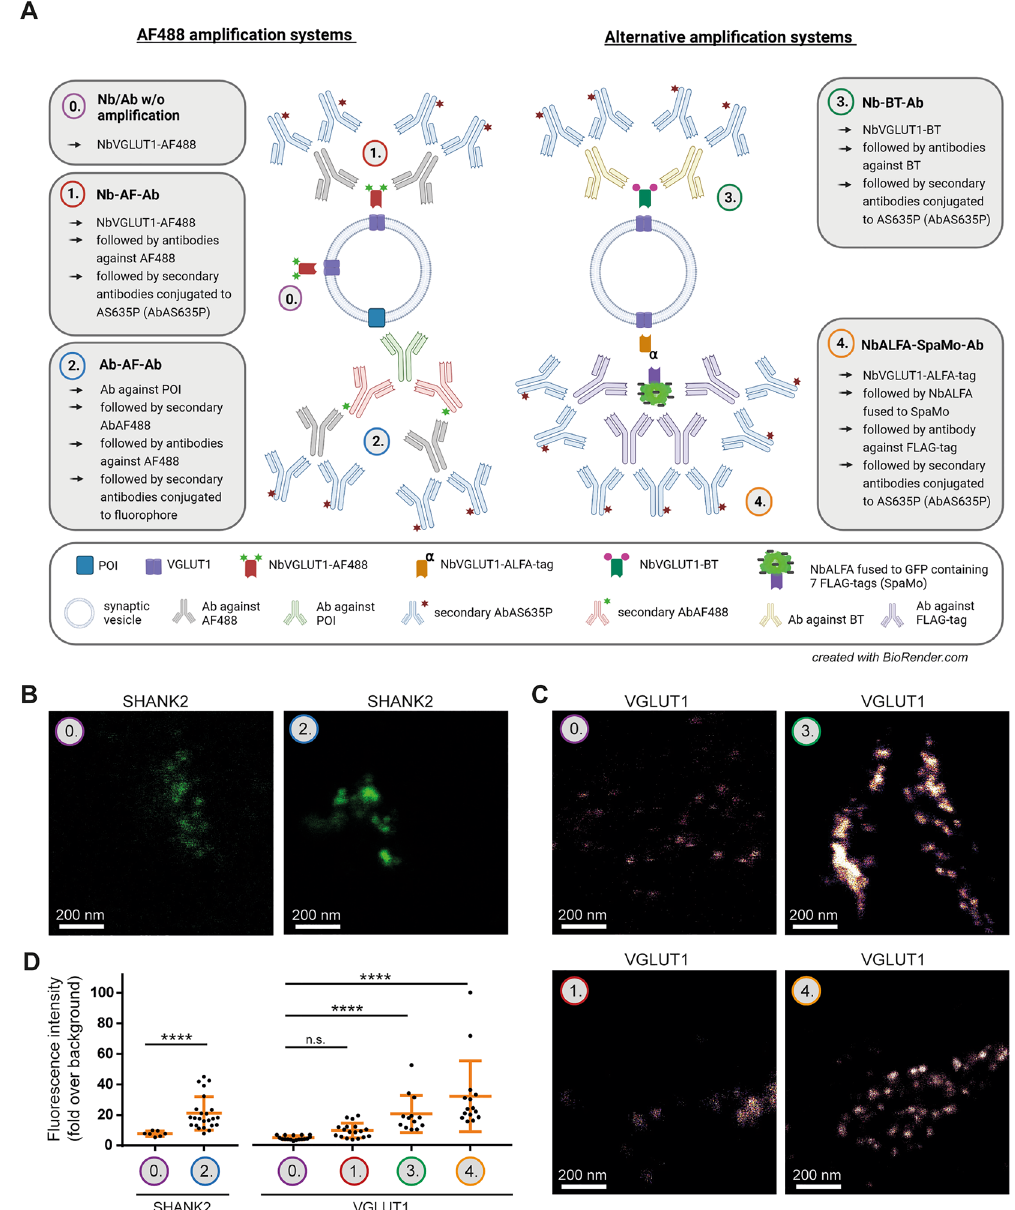
Figure 4. Pre-expansion labeling of presynaptic markers with different signal amplification systems in X10ht. ( A ) Schematic visualization of the different amplification systems. See the main text for more details. Final used fluorophores are Alexa Fluor488 (AF488) or Abberior Star635P (AS635P). ( B ) Representative confocal images of expanded neurons immunostained with either the antibody-AF488-based amplification system for SHANK2, or ( C ) with the different nanobody-based amplification systems detecting VGLUT1. ( D ) Quantitative analysis of SHANK2 with N = 7 images for 0. Ab w/o amplification, and N = 22 images for 2. Ab-AF-Ab from 3 experiments; N = 18 images for 0. Nb w/o amplification (VGLUT1) and 1. Nb-AF-Ab, N = 13 images for 3. Nb-BT-Ab, and N = 14 images for 4. NbALFA-SpaMo-Ab all to detect VGLUT1, with several ROIs analyzed per image generated from 2 experiments. Data are presented as single data points, mean ±